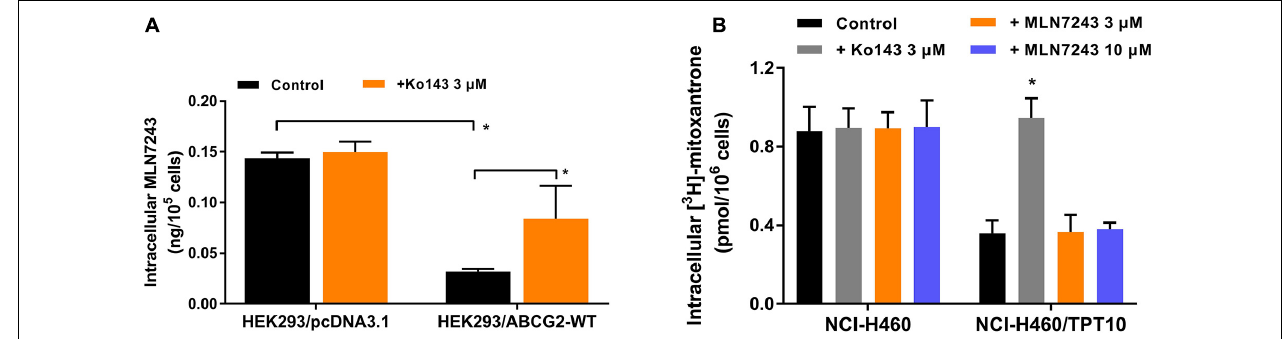
FIGURE 3 | MLN7243 was transported out from ABCG2-overexpressing cells but did not competitively inhibit the efflux of another ABCG2 substrate. (A) The intracellular accumulation of MLN7243 in HEK293/pcDNA3.1 and HEK293/ABCG2-WT determined by HPLC assay. (B) The intracellular accumulation of